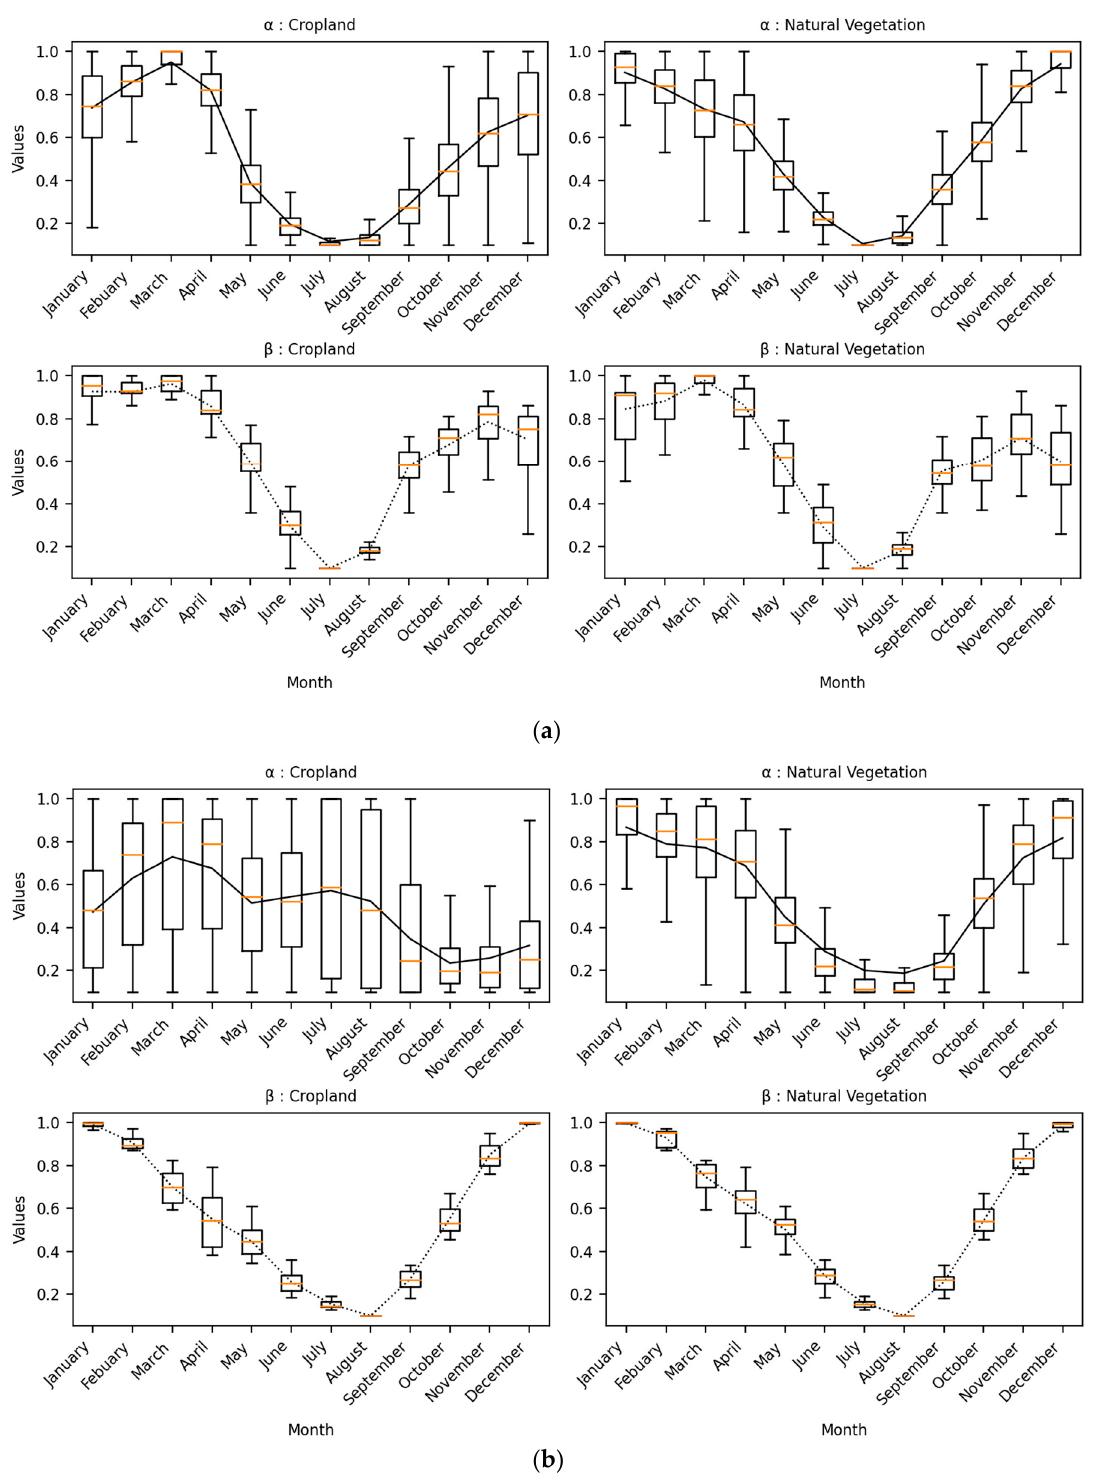
Figure 11. Illustration of α and β weight parameters for each type of land use (cropland and natural vegetation) for ( a ) Kairouan and ( b ) Andalusia.